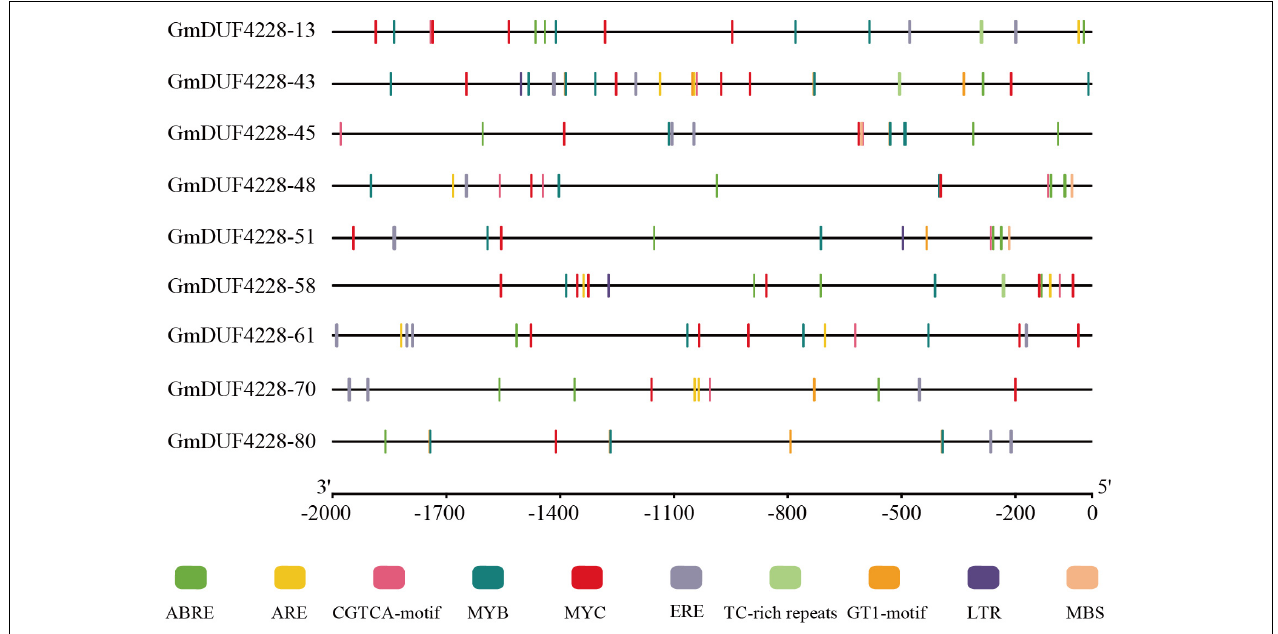
FIGURE 6 | Predicted cis -acting elements in GmDUF4228 promoters. Promoter sequences (2,000 bp) of nine GmDUF4228 genes were analyzed by PlantCARE. The scale at the bottom is used to infer the length of upstream sequences starting from the starting site of translation.